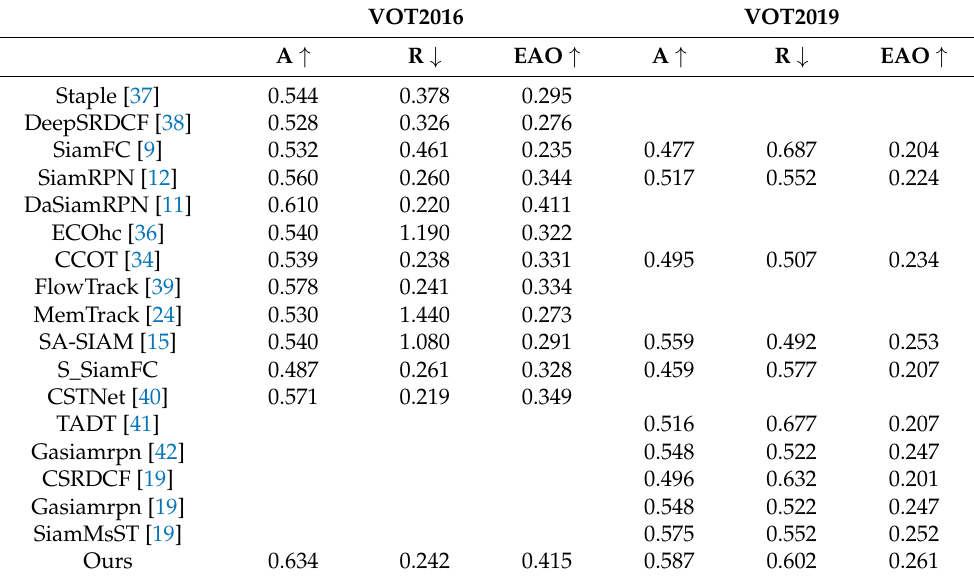
Table 2. Results on VOT benchmark. Red fonts indicate the top tracker. The blank boxes mean that these algorithms did not announce the results. ↑ indicates that the larger the parameter value, the better the tracker performance. ↓ indicates that the smaller the parameter value, the better the tracker